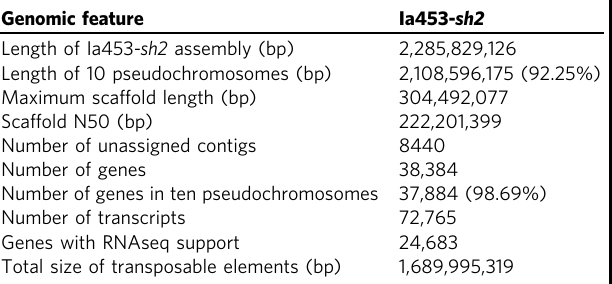
Table 1 The summary statistics of the sweet corn Ia453- sh2